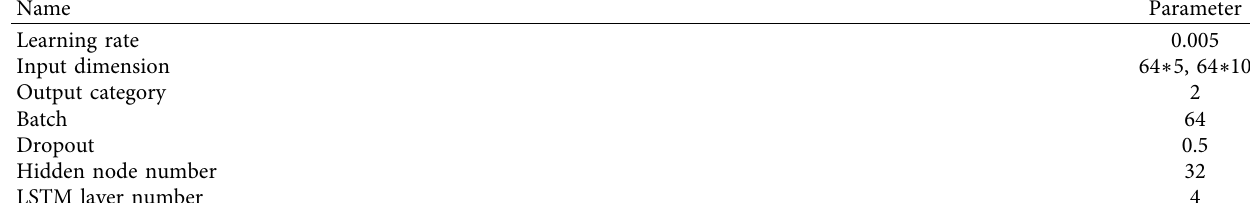
Table 2: LSTM emotion classification model specific parameter